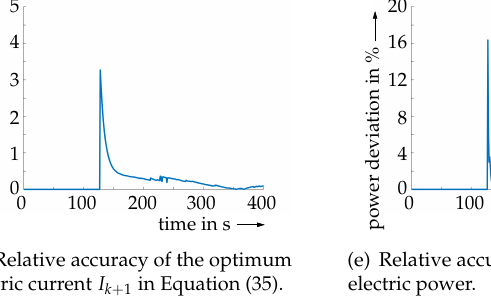
(a) Visualization of the transition point between pure online identification and maximum power point tracking.